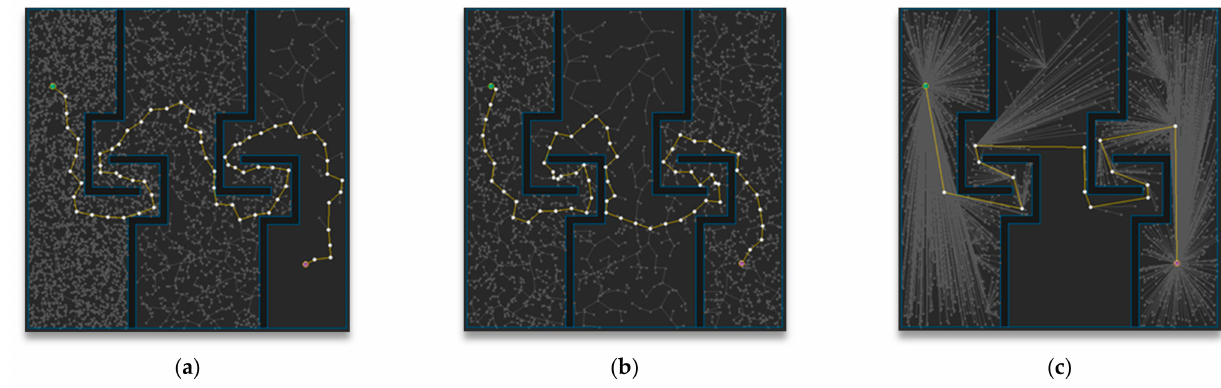
Figure 13. Experimental result of Map 3: ( a ) RRT; ( b ) RRT-Connect; ( c ) the proposed